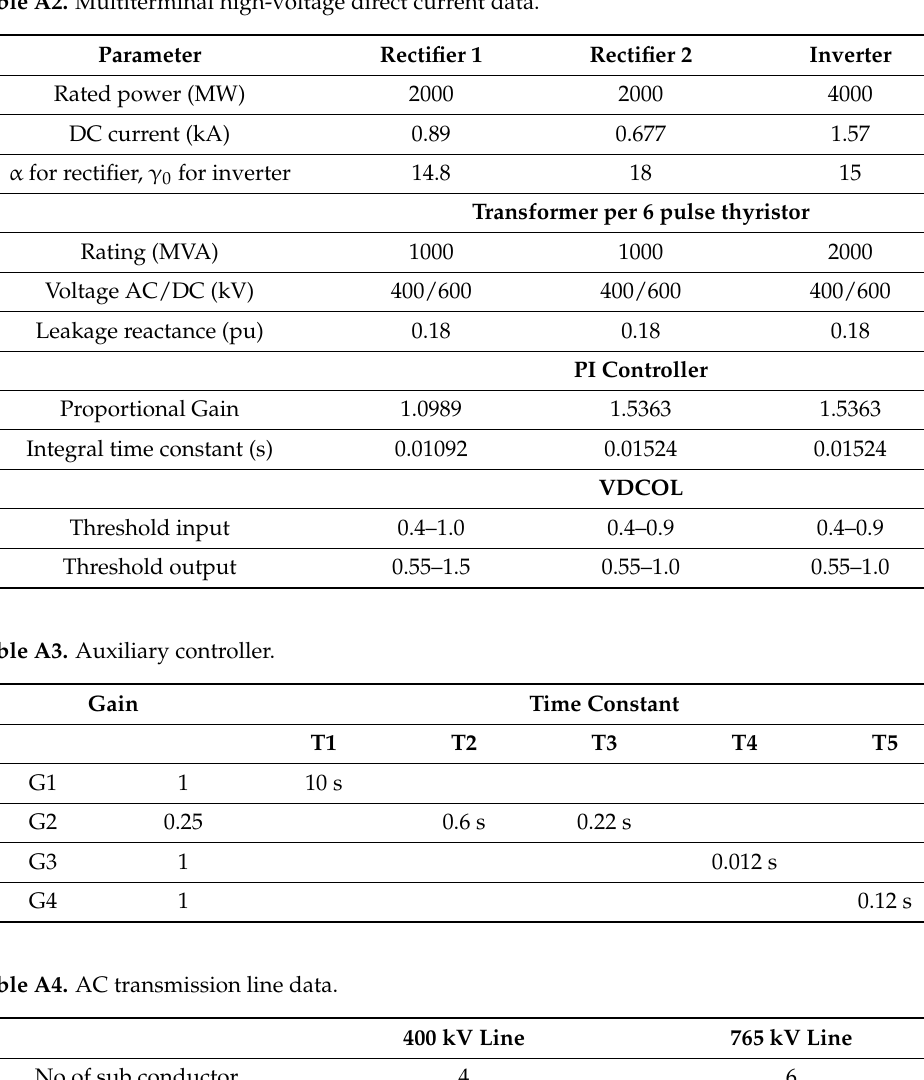
Table A2. Multiterminal high-voltage direct current data.